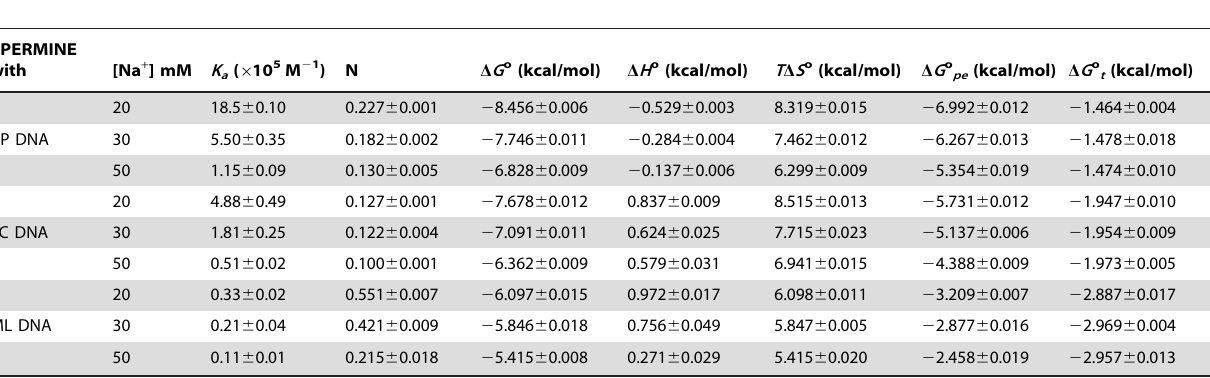
Table 4. ITC derived thermodynamic parameters for the binding of spermine to CP, EC and ML DNA at 293.15 K at different [Na + ] concentration a